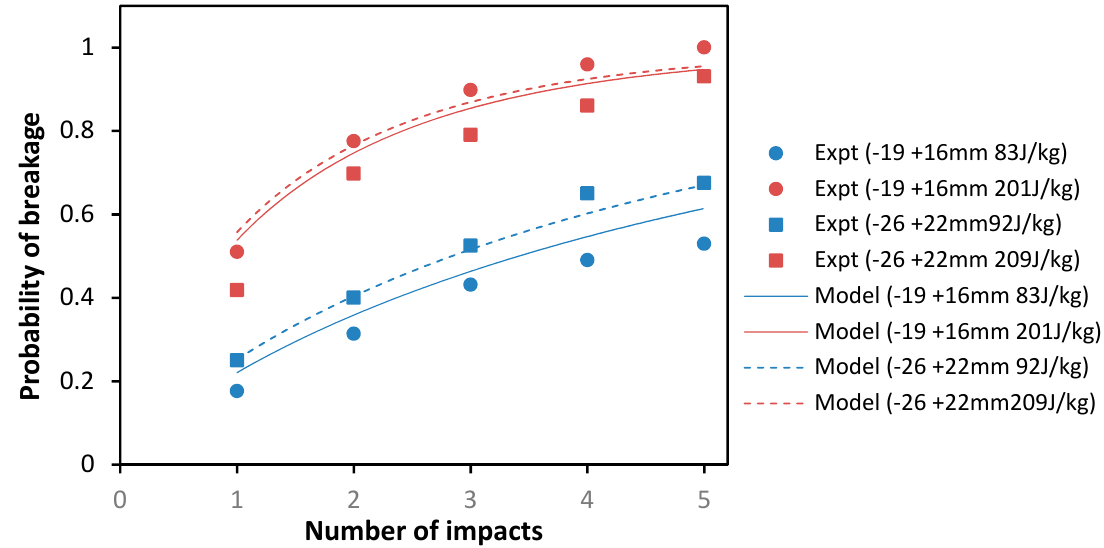
Figure 12. Comparison of gold waste rock breakage probabilities for two particle sizes at specific impact energy input.